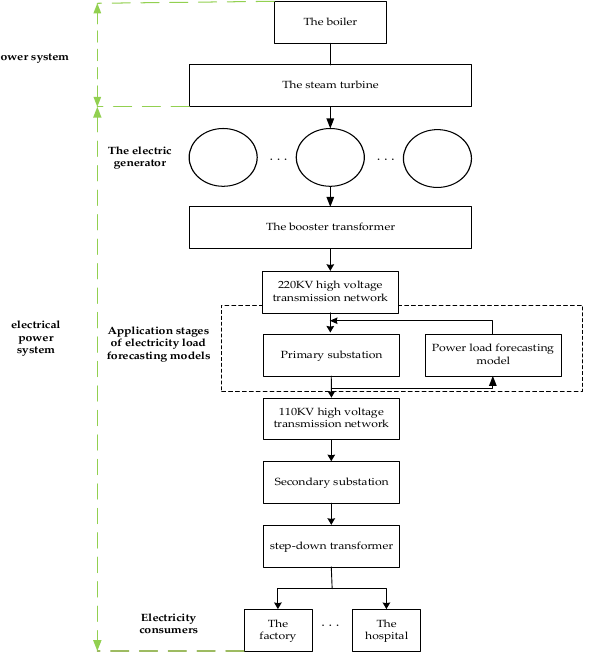
Figure 6. Flowchart for the transmission of electrical loads in the transmission grid.